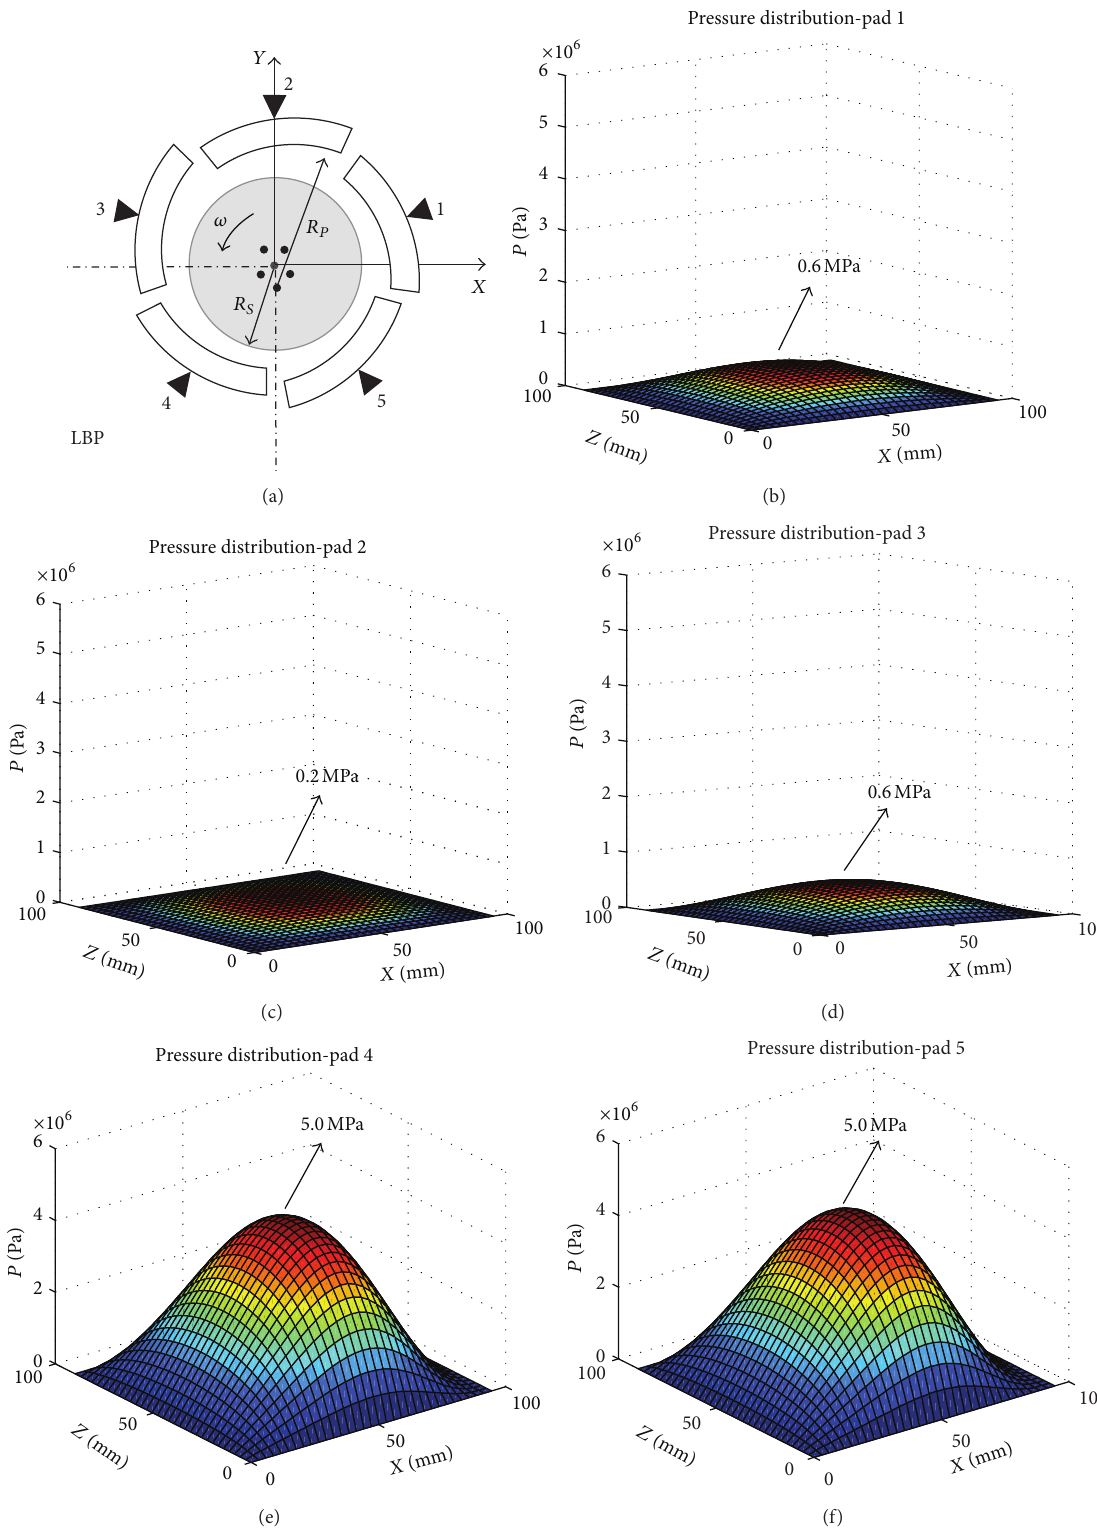
Figure 14: Pressure distribution on the pads obtained from the greater radial clearance and the maximum rotational speed: (a) bearing configuration; (b) pad 1; (c) pad 2; (d) pad 3; (e) pad 4; (f) pad